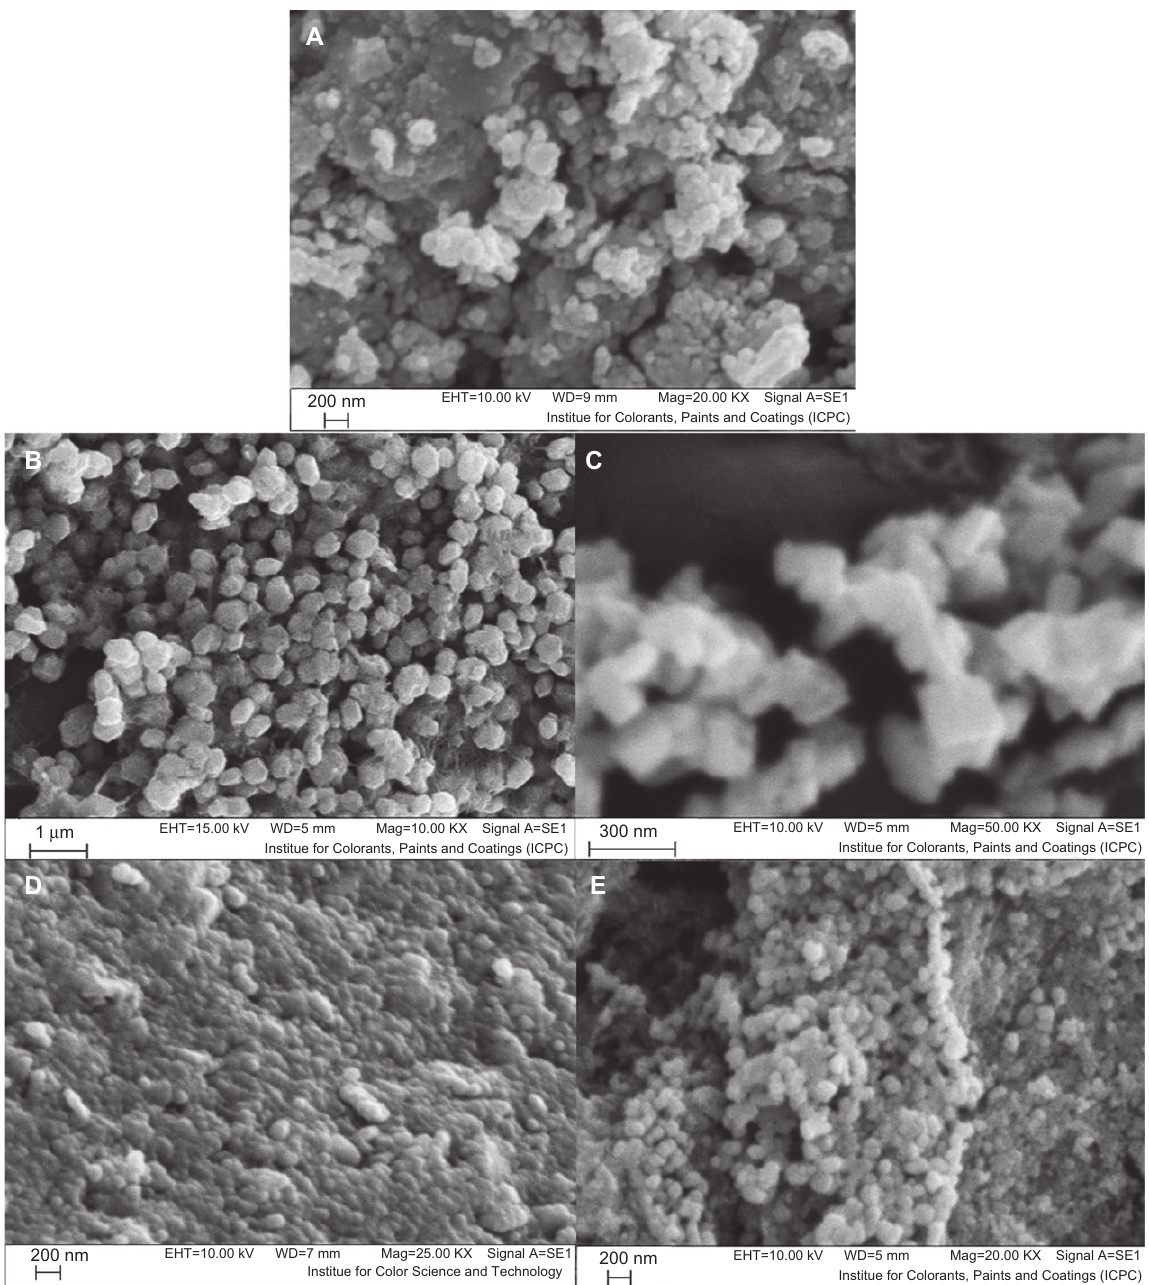
Figure 2 SEM images of the PbS nanocrystals synthesized (A) without thiophenol and with (B) 0.05, (C) 0.1, (D) 0.5 and (E) 1 m of